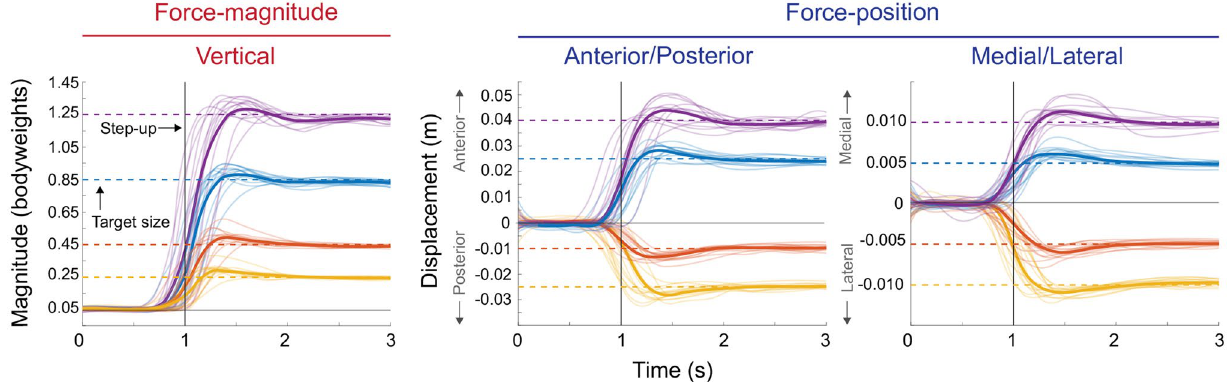
Figure 3. The average step-up response from each participant at each target step size (color lines) and the average of the average response (bold color lines). The vertical line represents when the target step function steps up from its base value of 0.05 bodyweights for force-magnitude control or 0 cm for force-position control to a new target step size (dashed lines). Participants could anticipate when the step target would step up to a new target size therefore the response could precede the visual step change. Here the first second before the step-up and the 2 seconds after are shown. Within this time frame, we evaluated the rise time, bandwidth, overshoot, steady-state error, and steady-state variability.